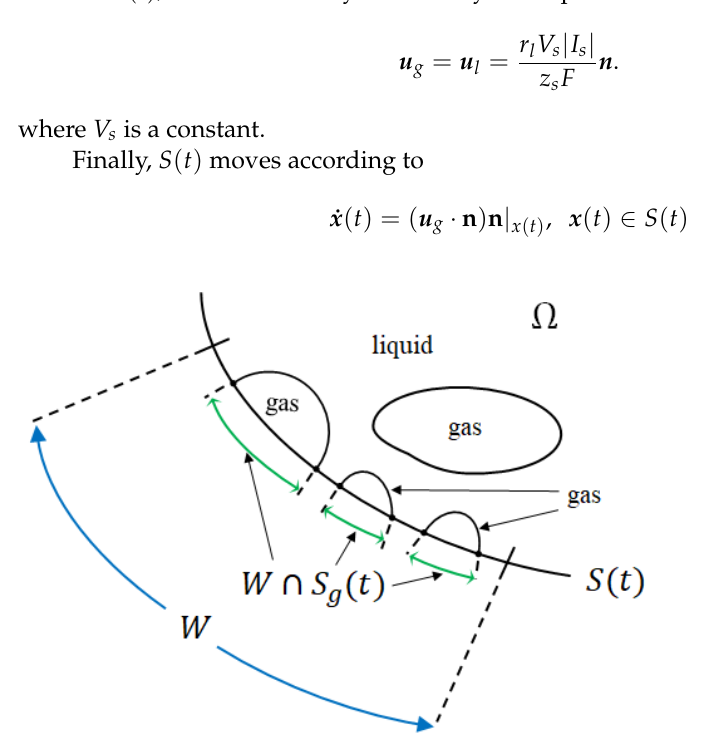
Figure 5. The reaction